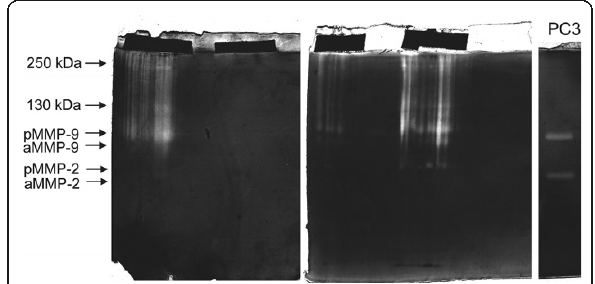
Figure 2 Zymogram analysis of biopsy prints . Two exemplificative gels, each one containing two tissue prints visible as dark strips in the stacking gel, are shown. The presence of discrete gelatinolytic activity is indicated on the left with the molecular weight or with the corresponding gelatinase. On the right the gelatinolytic pattern observed in conditioned medium from PC3 cells.